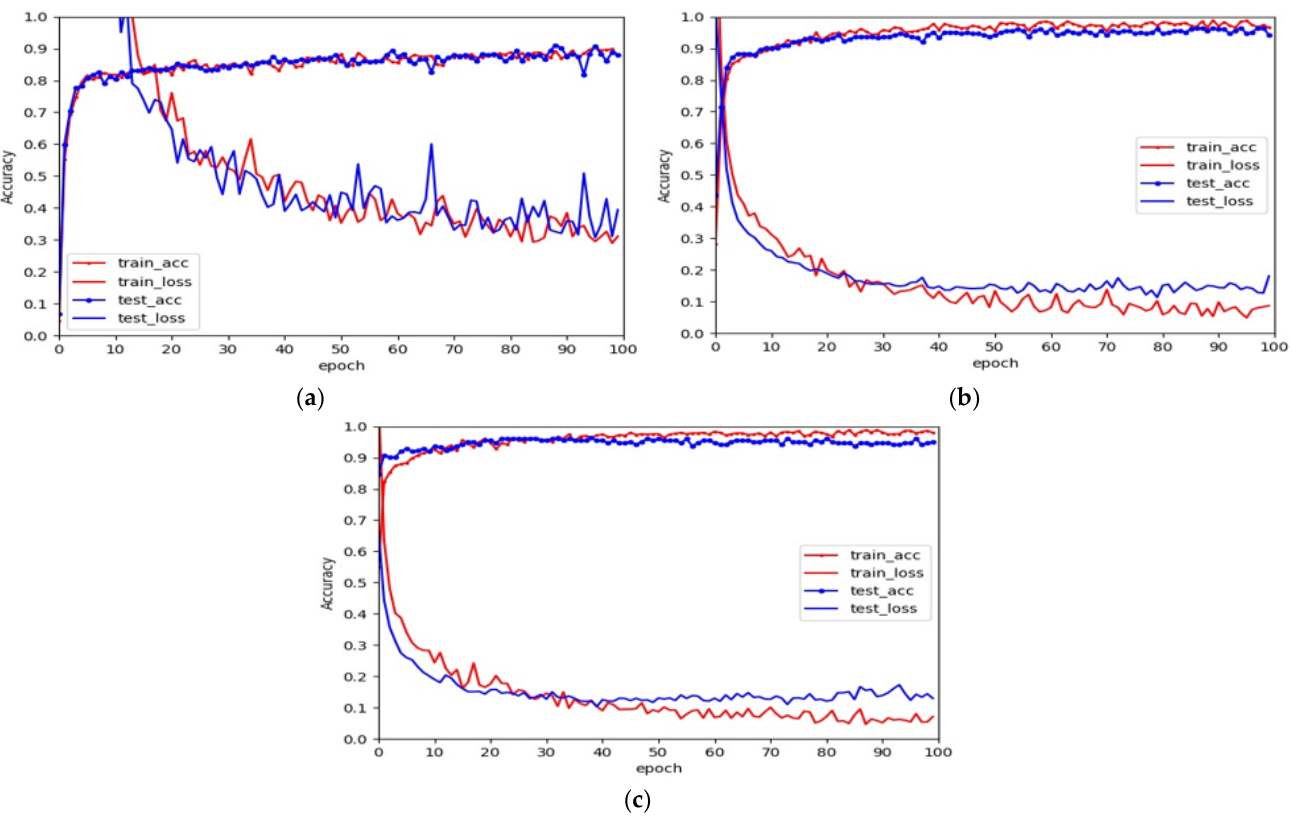
Figure 11. ( a ) Accuracy and loss function of the training sets and validation sets of the resnet18 network model trained with real side-scan sonar images. ( b ) Accuracy and loss function of the training and validation sets of the pre-trained resnet18 network model fine-tuned with real side-scan sonar images. ( c ) Accuracy and loss function of the training sets and validation sets of the pre-trained resnet18 network model fine-tuned with real side-scan sonar images and “simulated side-scan sonar images”.